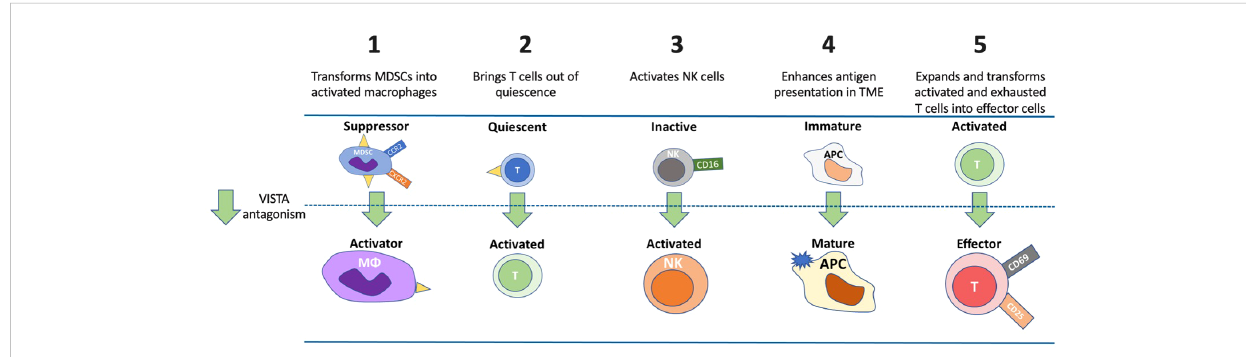
FIGURE 4 Potential mechanisms and impacts of VISTA antagonism. VISTA plays multiple roles in controlling immune responses. VISTA antagonism 1) induces a shift in MDSC function, reduces MDSC suppressive activity and enhances the potential for improved antitumor effect through macrophage activation, 2) lowers the threshold of activation for quiescent T cells and allows a greater percentage of T cells to respond to neo-antigens, 3) activates NK cells that may result in independent anticancer effects via antibody-directed cellular cytotoxicity, 4) enhances APC maturation to effectively present antigens to induce a T-cell response, and 5) expands and transforms activated and exhausted T cells into effector cells. APC, antigen presenting cell; CCR2, C-C motif chemokine receptor; CD, cluster of differentiation; CXCR2, CXC motif chemokine receptor 2; MDSC, myeloid-derived suppressor cell; M F , macrophage; NK, natural killer